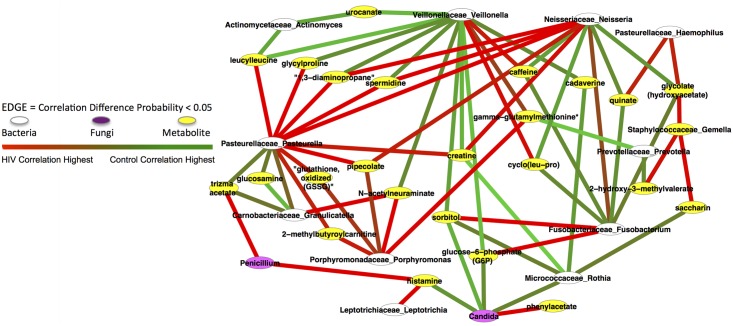
The Correlation Difference Probability Network (CDPN).Represents the significant Correlation Difference Probability Network for all Control vs. HIV cohort feature pair correlations (p<0.05). Fig 4 is the entire network. The position of node and edge length or not significant. Green edges indicate the Control Correlation was positive and the HIV cohort correlation was negative or very weakly positive. The red edges indicate the HIV cohort correlation was positive and the Control cohort correlation was negative or very weakly positive.